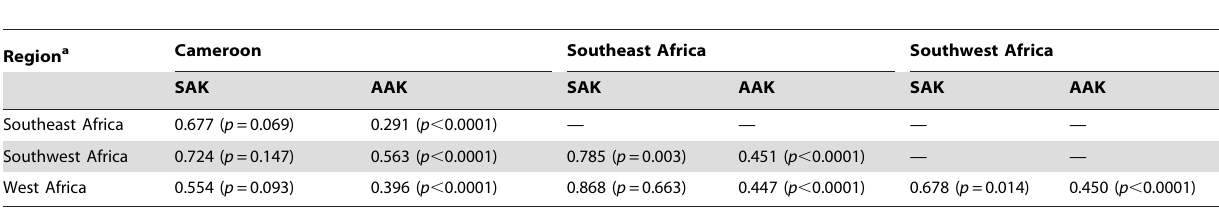
Table 3. Regional differentiation at microsatellite variation linked to SAK and AAK alleles as calculated by Nei’s standard genetic